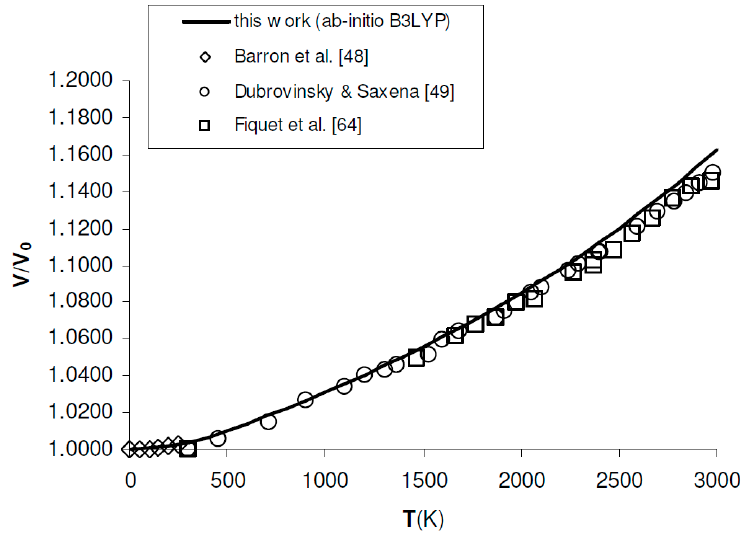
Figure 3. Ab initio B3LYP relative volume thermal expansion (V/V 0 ) of MgO, as compared to low-T to high-T experimental data [48,49,64]. Reference volume is V 0 = 75.762 Å 3 = 11.406 cm 3 /mol (T = 0 K, P = 0 GPa, including ZPC).